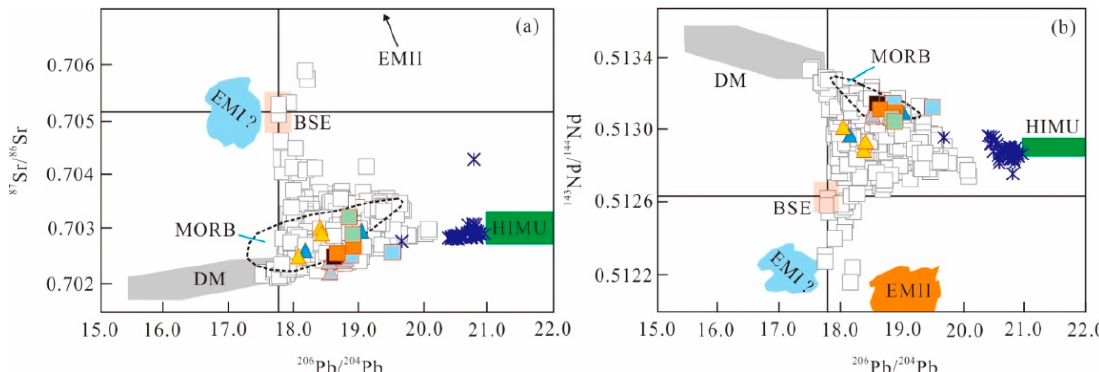
Figure 3. 206 Pb/ 204 Pb versus 87 Sr/ 86 Sr ( a ) and 206 Pb/ 204 Pb versus 143 Nd/ 144 Nd ( b ) diagrams (after [53]) of the basalts from the SMAR at 18–21°S. The Atlantic MORB and the St. Helena igneous rock values are from http://georoc.mpch-mainz.gwdg.de/georoc/Entry.html. Symbols are the same as in Figure 2.